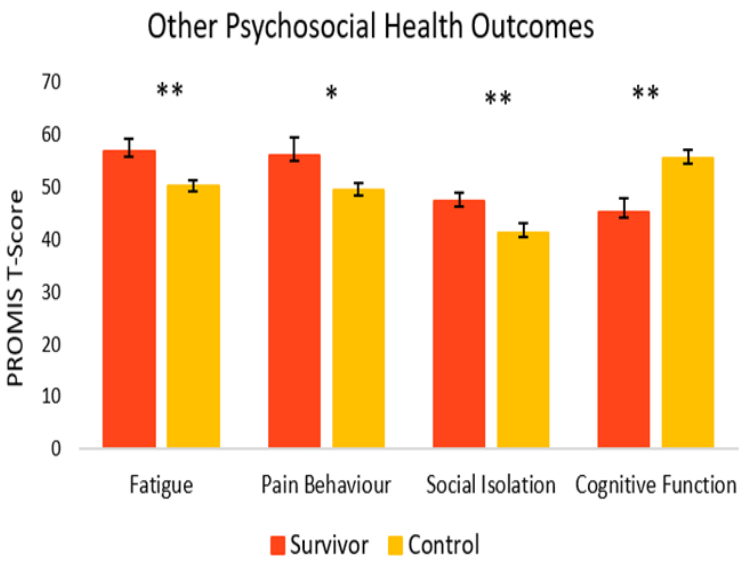
Figure 6. Psychosocial outcomes in cancer survivors and healthy controls. Group means are presented. Error bars represent standard error of the mean (SEM). Significance is denoted by ** at the p < 0.01 level, and * at the p < 0.05 level Group n = 8–18.